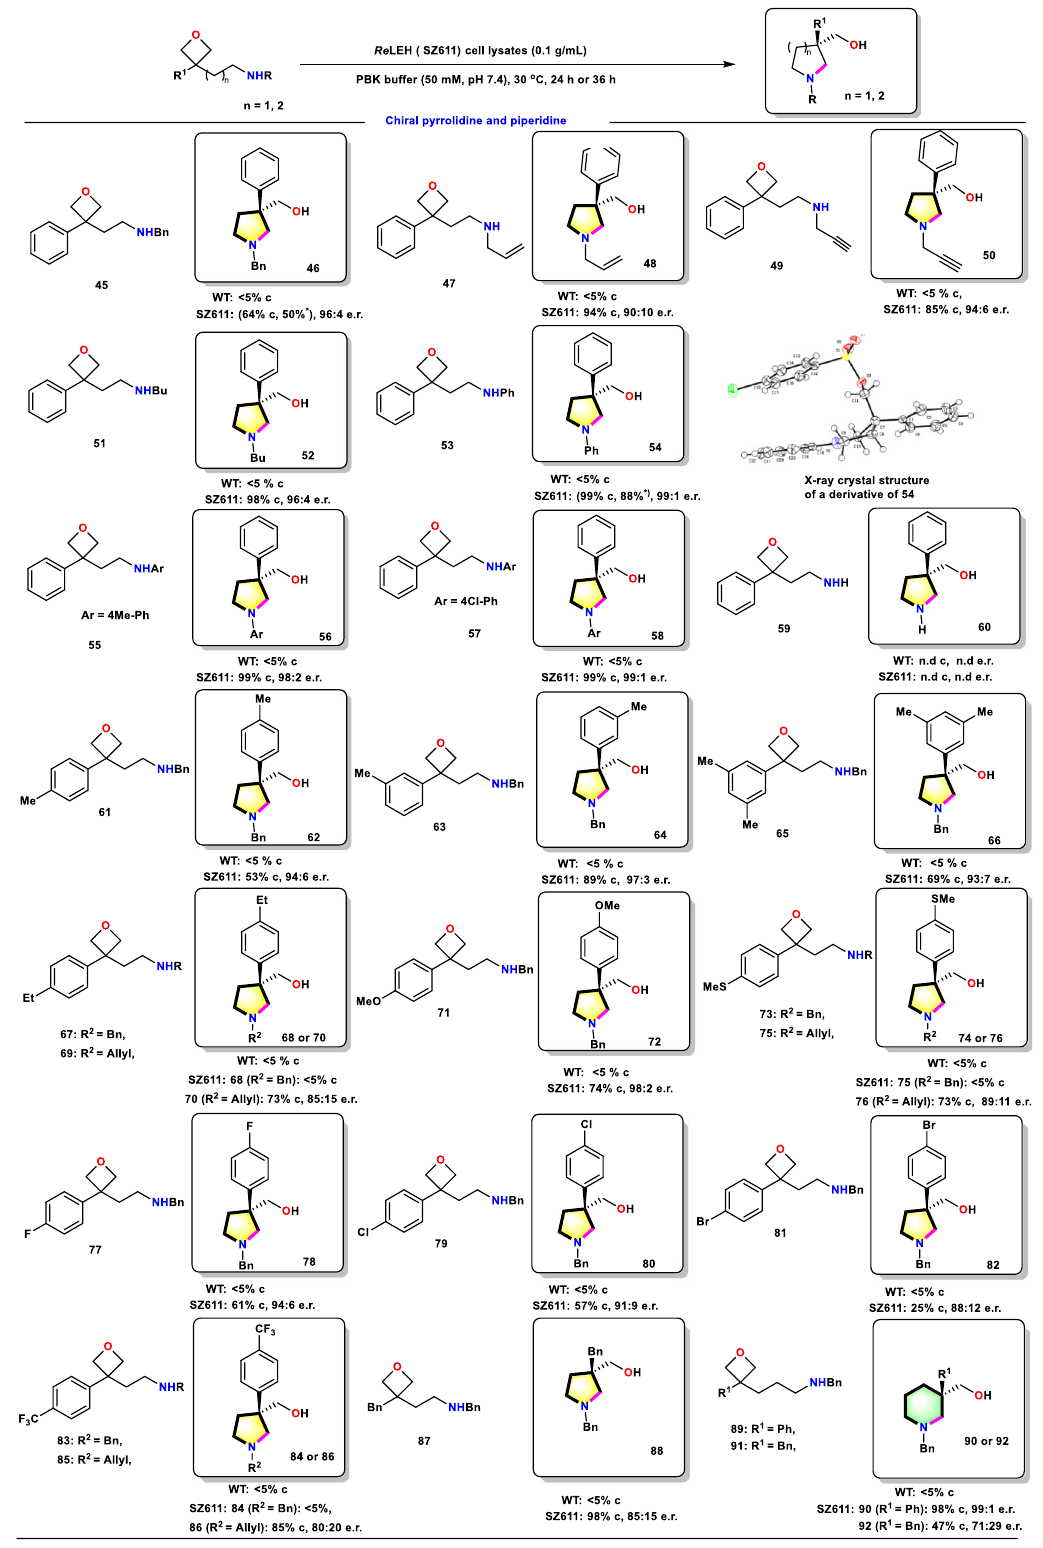
Fig.5|Substratescopeof Re LEHvariantsinthesynthesisofchiralpyrrolidines. Reaction conditions: Re LEH (0.1g/mL wet cell), substrate (5mM), PBK buffer (50mM, pH 7.4), Lysozyme (1mg/mL), DNase I (6U/mL), 0.5mL total volume,